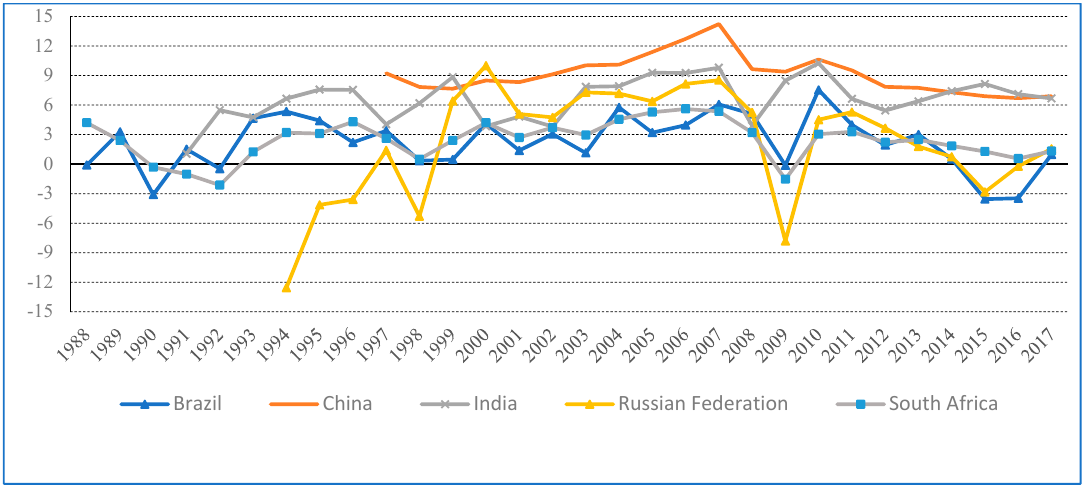
Figure 1. FDI Inflows in India and China 2011–2015, US$ billion. Source: Own elaboration using FDI markets data.